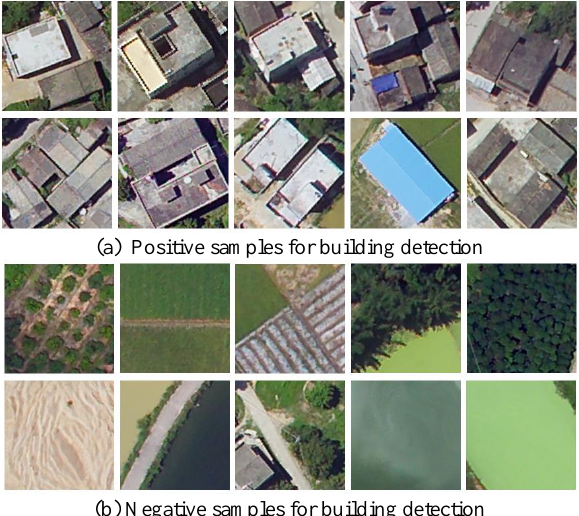
Figure 5. Some examples of samples for targets detection. (a) Positive samples. (b) Negative